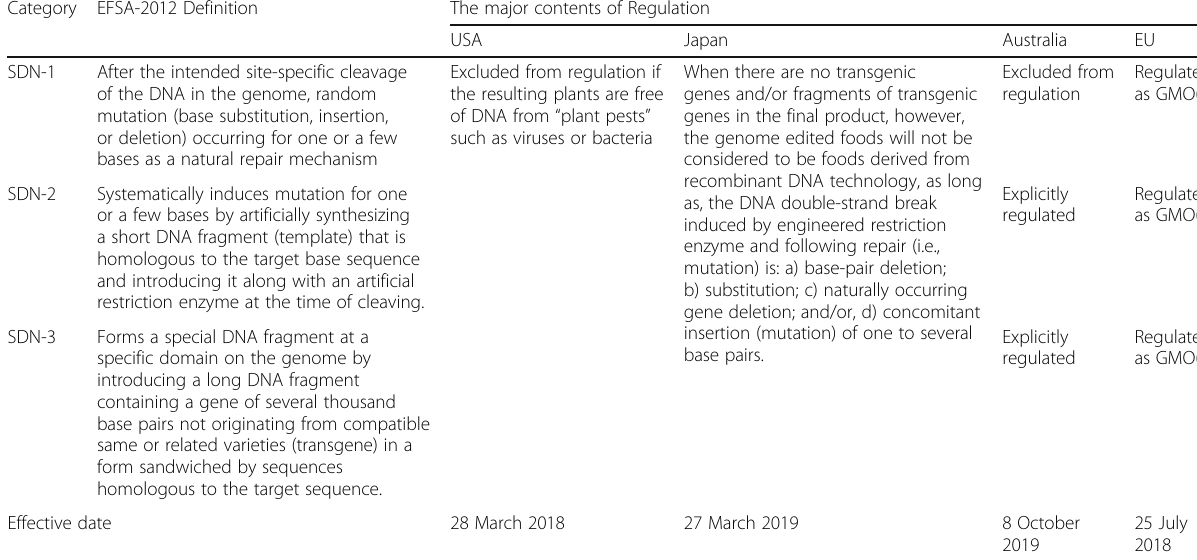
Table 3 Gene- edited crop regulation status on the basis of SDN Category EFSA-2012